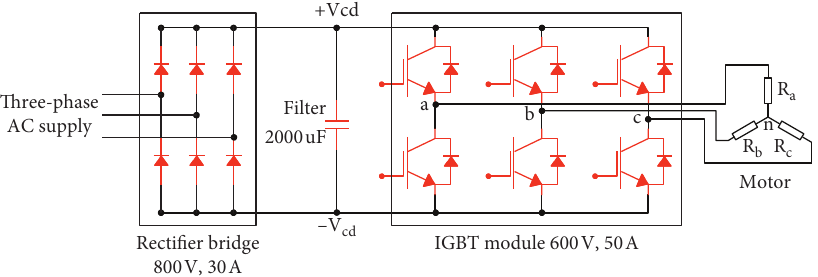
Figure 7: Power circuitry for the servodrive